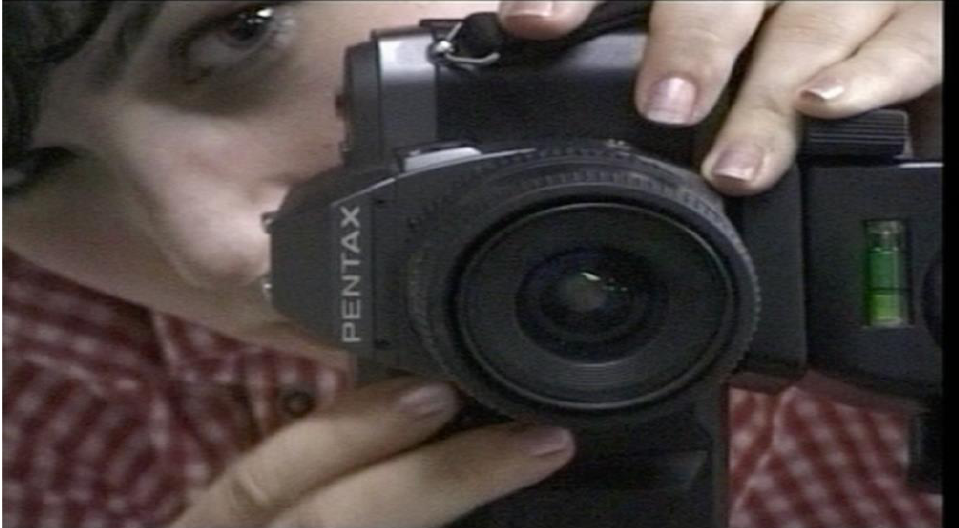
Figure 14. Oreet Ashery , What Is It Like for You? , 2000, 04:06. Screen shot, 00:08 min.